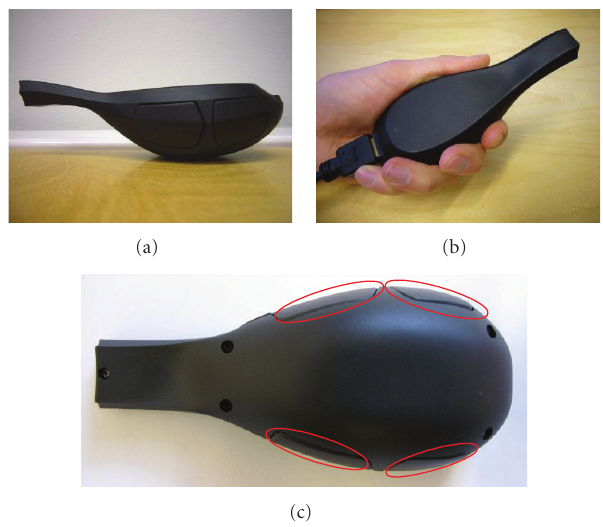
Figure 1: (a) Side view of the prototype device, (b) a person holding it, and (c) the bottom-up view with circles showing the placement of the